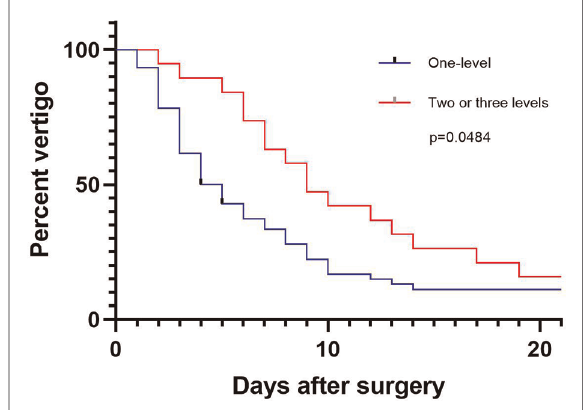
FIGURE 3 Percentage of patients with residual vertigo within three weeks after ACDF.